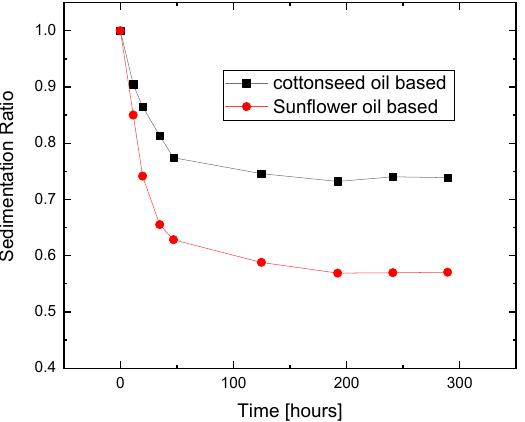
Figure 11. Sedimentation ratio as a function of time for the organic oil blend-based MR fluid samples.